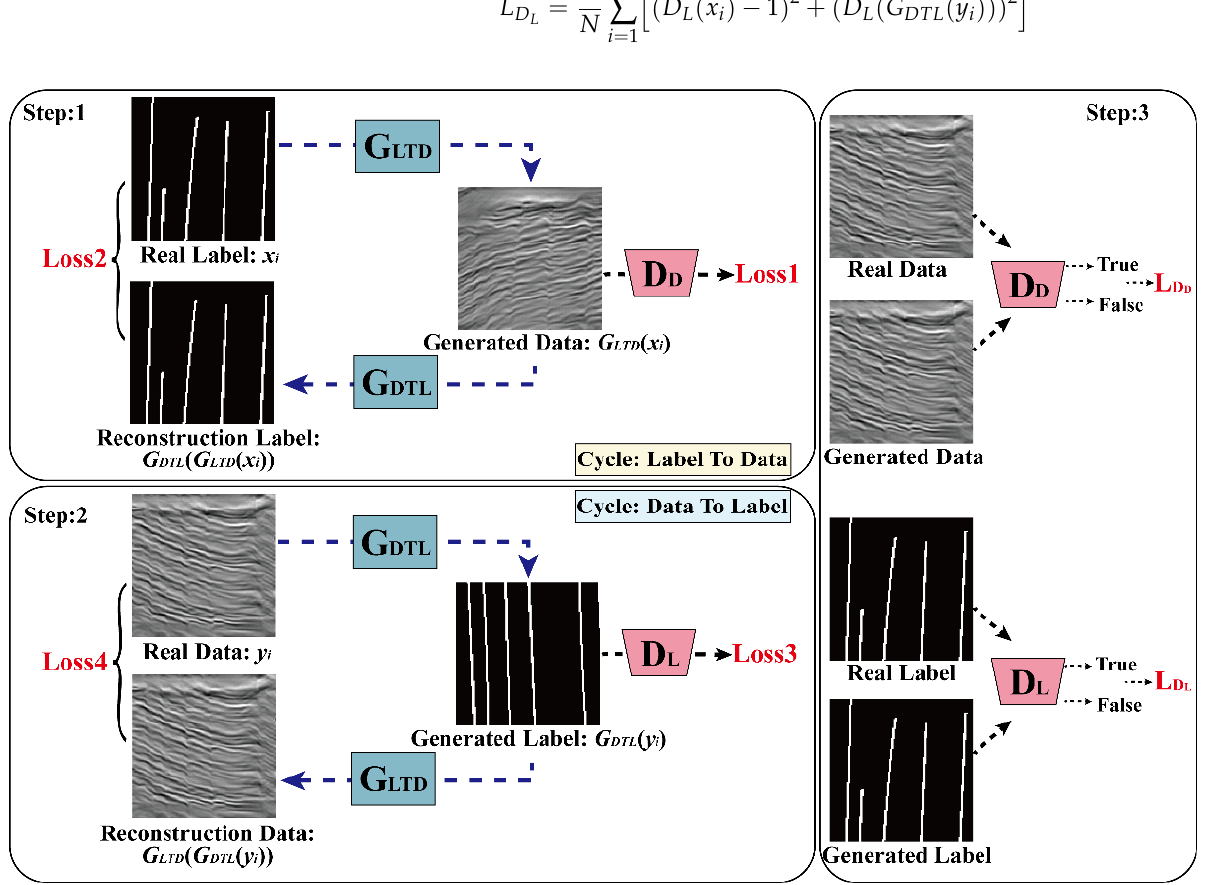
Figure 2. Label-to-data network structure.